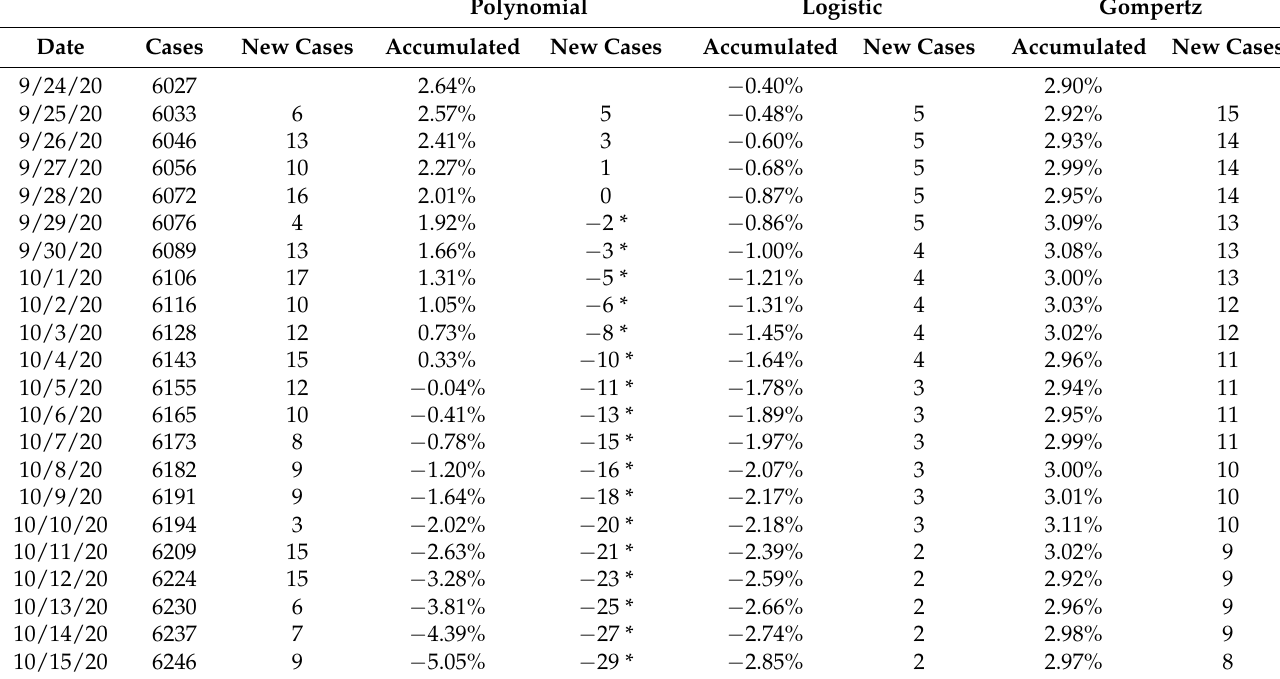
Table 6. Daily new COVID-19 cases predicted from total cumulative cases in the state of Campeche.